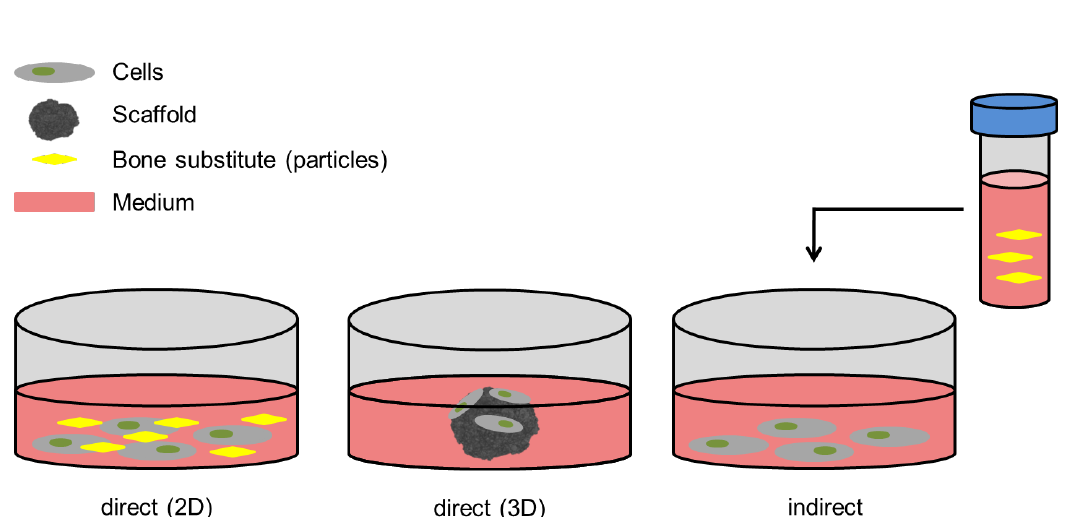
Figure 1. In-vitro evaluation models. 2D culture allows physical contact, mostly with particles of the respective bone substitute, whilst cells seeded on scaffolds are cultivated in 3D culture conditions. The indirect culture setting allows evaluation of the dissolution products of the materials that underwent incubation in the respective medium for a certain amount of time before the particle-free medium is transferred to the cells (indicated by the black arrow).